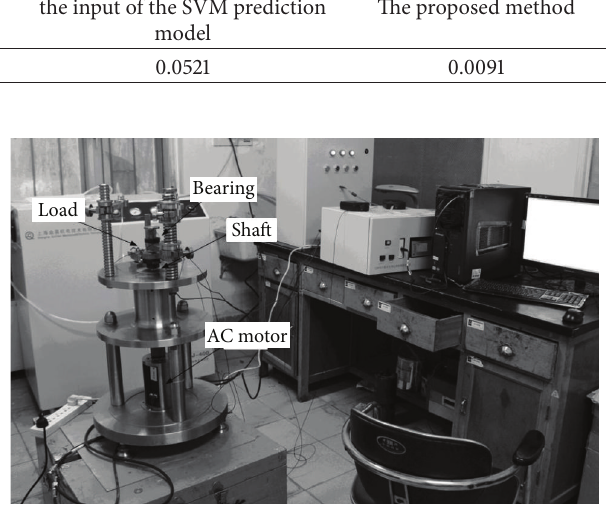
Figure 16: Bearing test